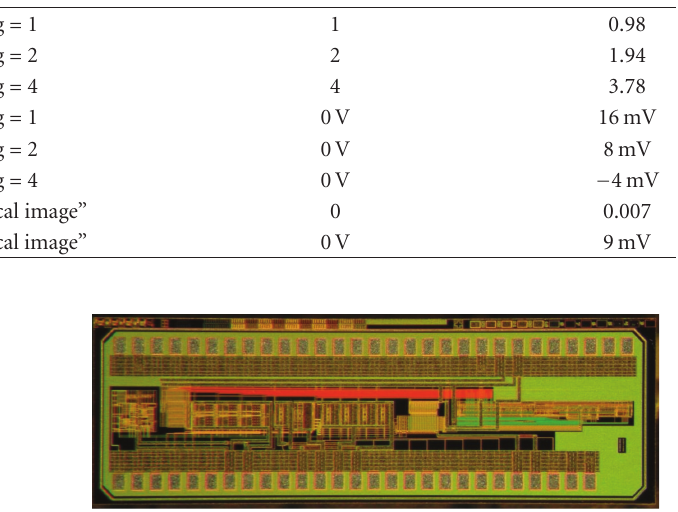
Figure 8: Test chip photograph. The chip size is 4.7mm × 1.3 mm.